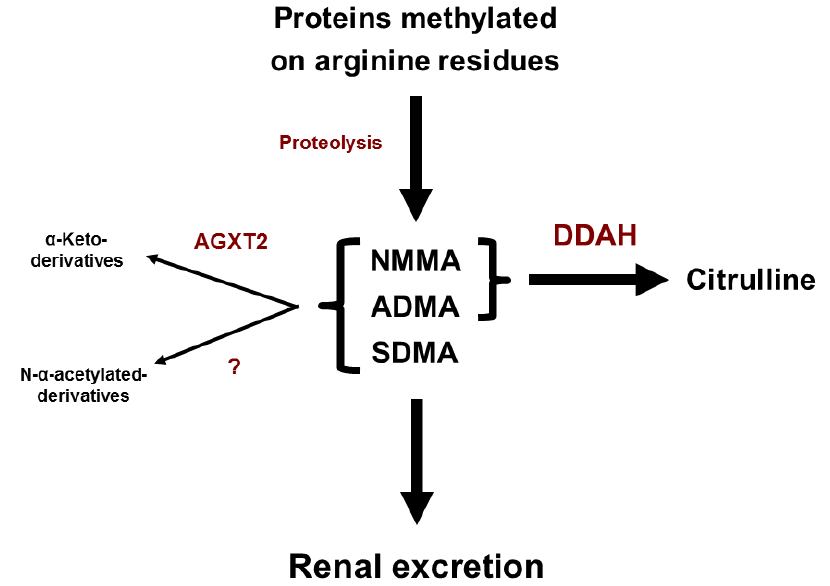
Figure 1. Metabolism of endogenous methylarginines. N G -monomethyl- l -arginine (NMMA), asymmetric N G ,N G -dimethyl- l -arginine (ADMA) and symmetric N G ,N’ G -dimethyl- l -arginine